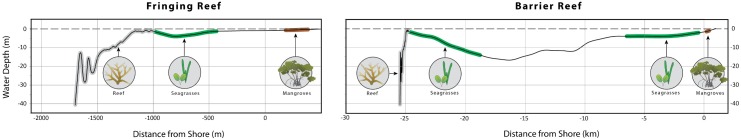
Idealized bathymetric profiles of fringing and barrier reefs.